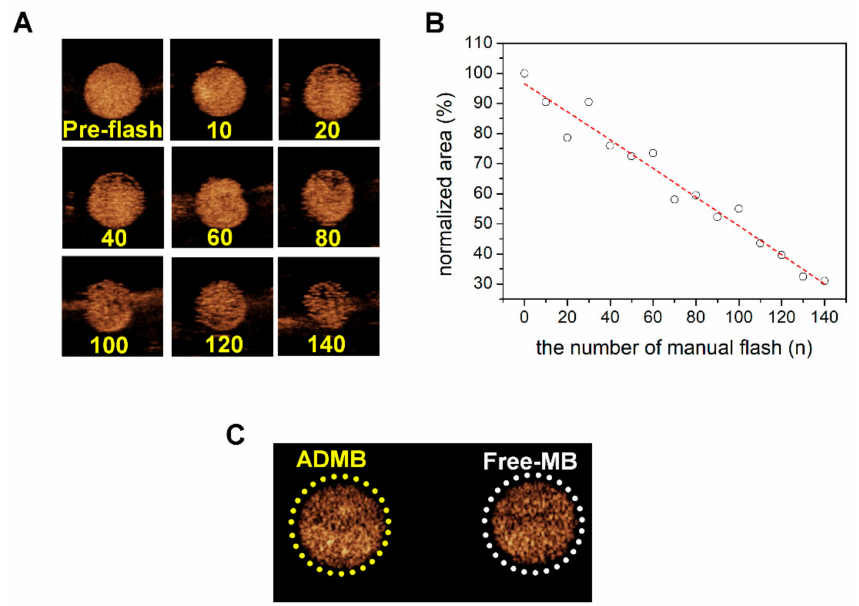
Figure 3. Contrast-enhanced ultrasound images and relative quantification of ultrasound images. ( A ) contrast-enhanced ultrasound images captured at varying numbers of manual flashes. ( B ) Relative quantification of ultrasound image. ( C ) Ultrasound image of the ADMB complex and the free